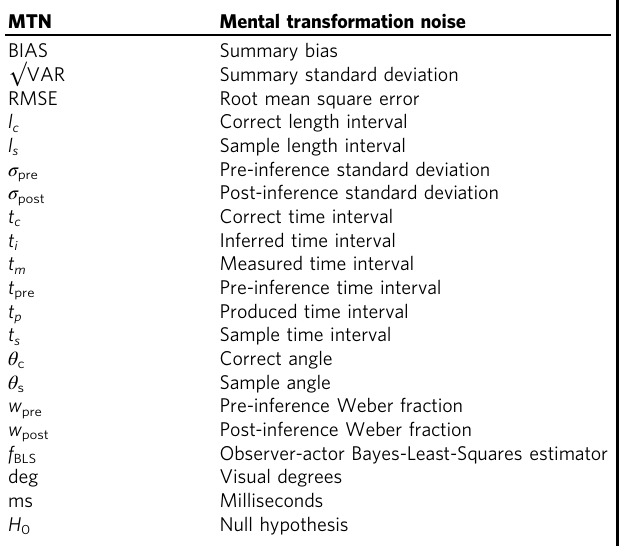
Table 1 Variables and